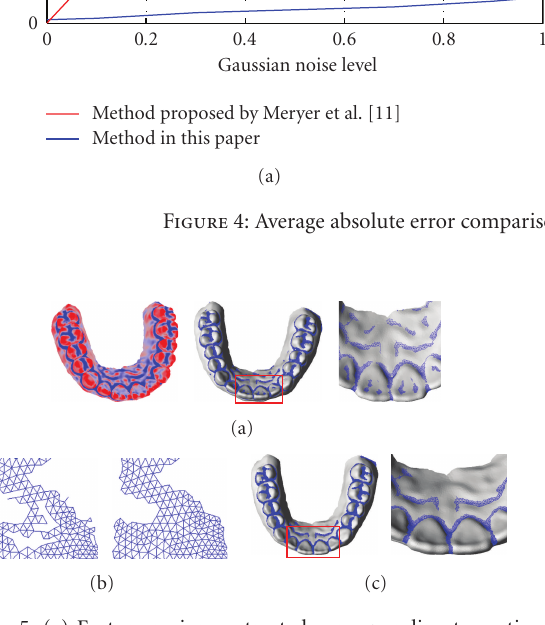
Figure 5: (a) Feature regions extracted corresponding to vertices marked with blue in the minimum curvature color map. (b) Feature region before and after being applied for opening and closing operation; (c) Feature regions of (a) after being processed